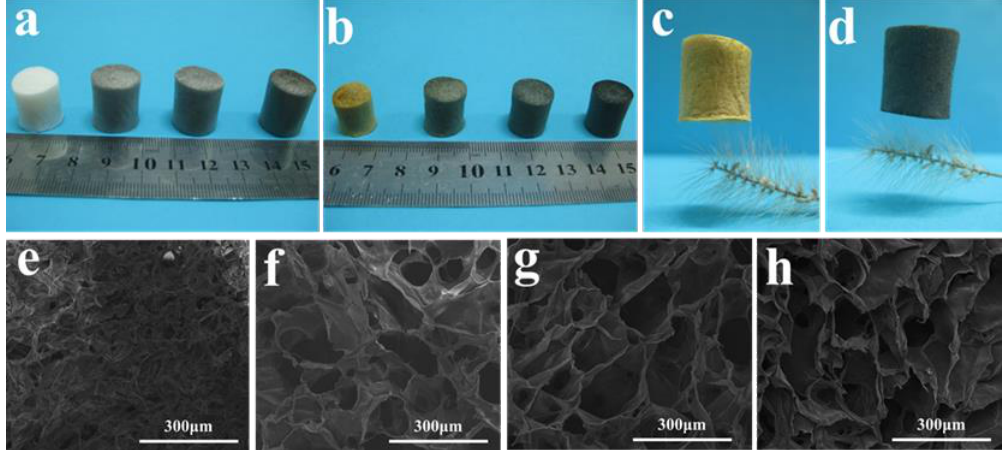
Figure 1. Macroscopic and microscopic structures of GIAs. Digital photograph of GIAs ( a ) before imidization and ( b ) after imidization. Digital images of GIA 0 ( c ) and GIA 2 ( d ) rested on a bristlegrass. SEM images of GIA 0 ( e ), GIA 0.5 ( f ), GIA 1 ( g ) and GIA 2 ( h